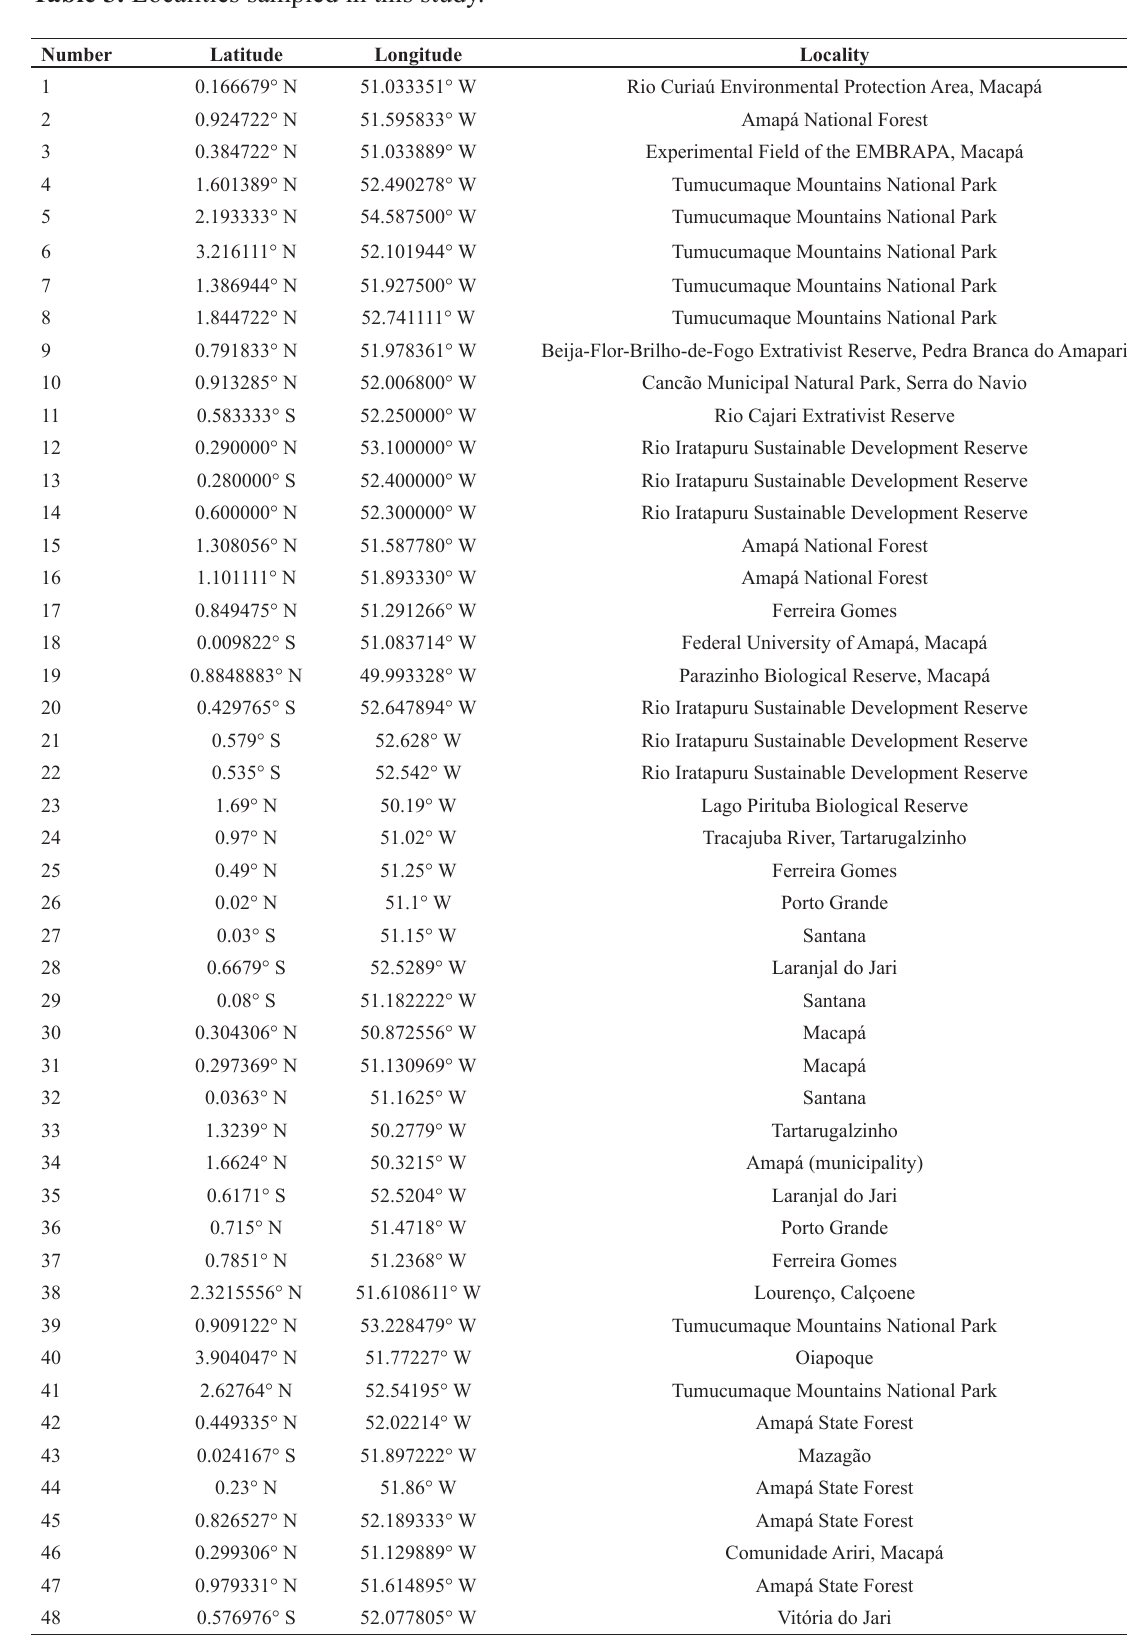
Table 3. Localities sampled in this